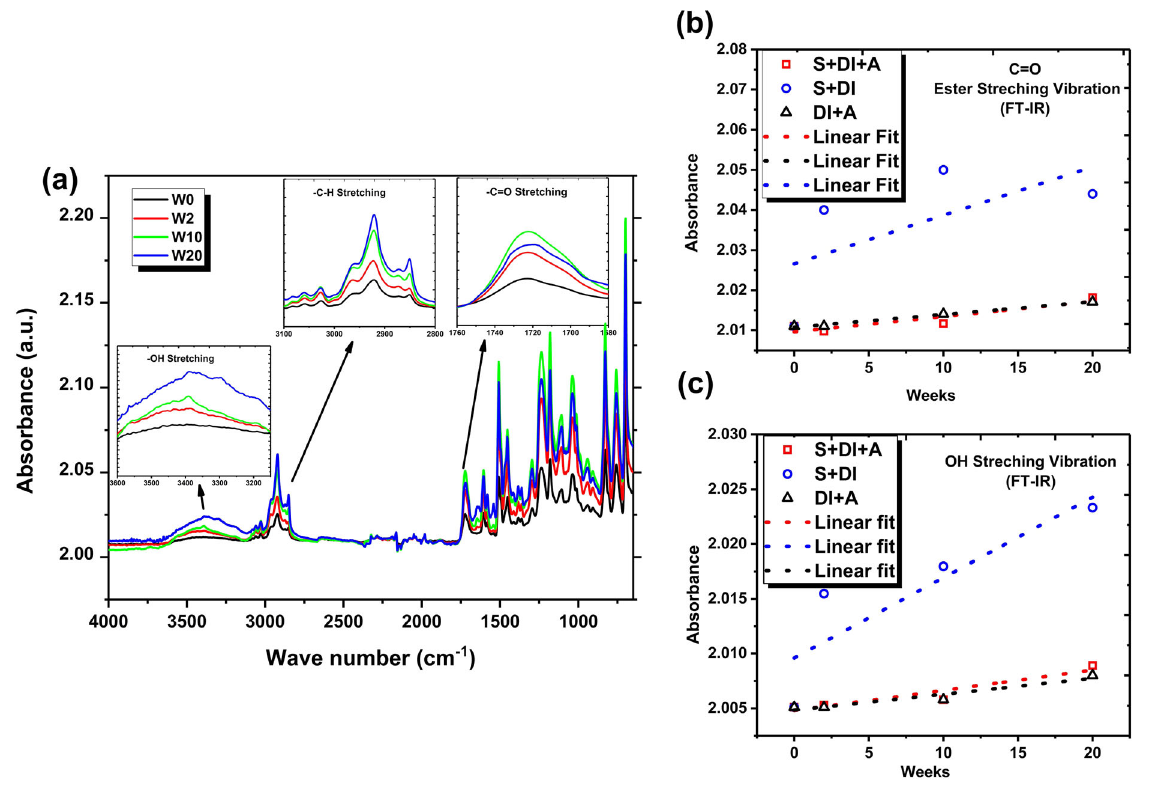
Fig. 7 Attenuated total re fl ection Fourier-transform infrared spectroscopy (ATR-FTIR) analysis of carbon fi ber-reinforced vinyl ester composites. a Superimposed ATR-FTIR spectra of carbon fi ber-reinforced vinyl ester composites in soil solution with deionized water (S + DI) after different exposure times con fi rm peak broadening and increase in peak intensity. The characteristic peaks corresponding to – OH stretching (moisture), – C – H stretching (vinyl), and – C = O stretching (ester) are shown in the insets of a . Peak intensity increased and broadened for the characteristic peak of vinyl ester corresponding to C = O stretching vibration (1726 cm − 1 ) 88 with increasing exposure time (from week 0 to week 20) when samples were exposed to microorganisms (S + DI samples). Similar increases observed in peaks corresponding to aromatic and aliphatic C – H stretching (2800 – 3100 cm − 1 ) and O – H stretching (3200 – 3600 cm − 1 ) 88 . Increase in absorbance intensities with exposure time corresponding to b − C = O stretching vibration, and c – OH stretching of carbon fi ber-reinforced vinyl ester composites with linear fi t after exposing them to different conditions: autoclaved soil solution with deionized water ( = − S + DI + A), soil solution with deionized (O-S + DI), and autoclaved deionized water ( Δ -DI +